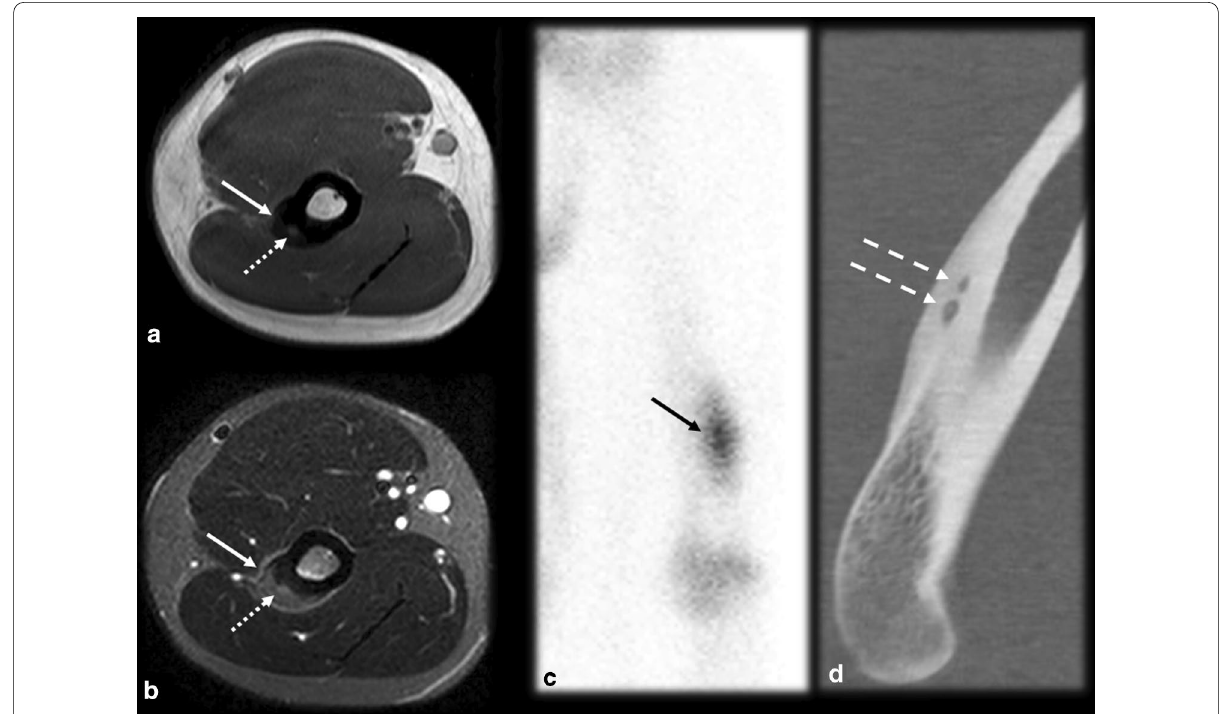
Fig. 3 Multicentric osteoid osteoma. A 26-year-old male handball player with lateral elbow and arm pain for 3 months. Orthopedists suspected lateral epicondylitis or a stress reaction. MRI T1 ( a ) and T2 FS ( b ) showed cortical thickening on the lateral supracondylar crest with corticoperiosteal edema (arrow) and small foci of intermediate signal intensity (dotted arrow), which raised the suspicion for OO. Scintigraphy ( c ) evidenced the double density sign (black arrow), which cannot be used to distinguish between single and multicentric OO. CT ( d ) detected two nidi (dashed arrows), confirming the diagnosis of multicentric